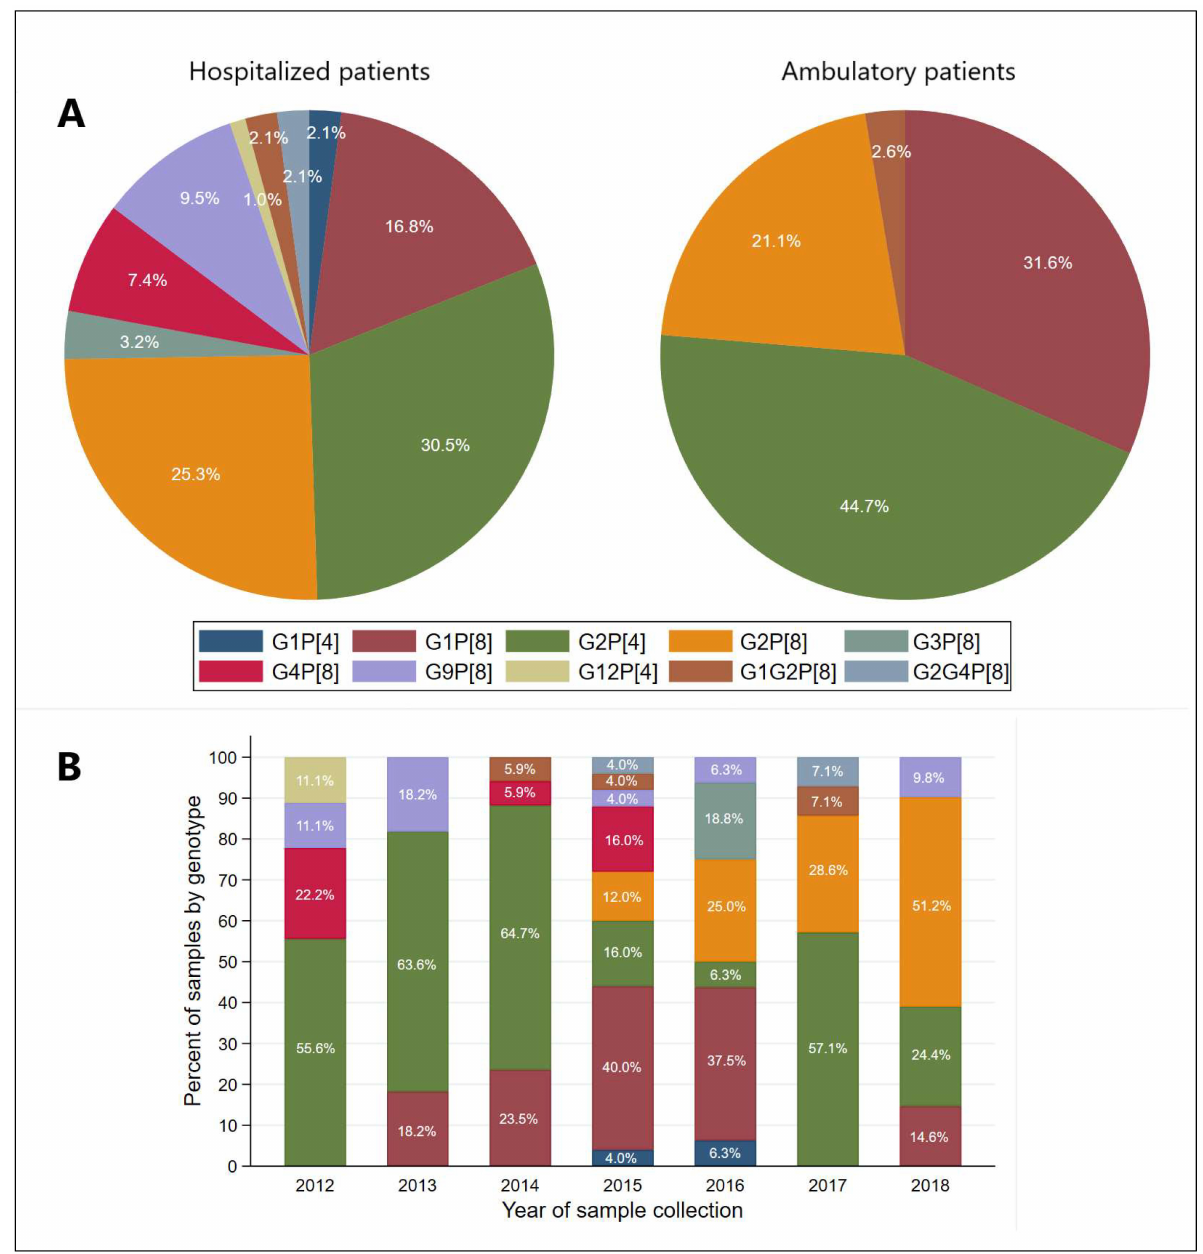
Figure 2. Rotavirus genotype distribution among the genotyped samples from hospitalized and ambulatory-treated patients ( A ) and yearly distribution of genotype by the year of sample collec- tion ( B